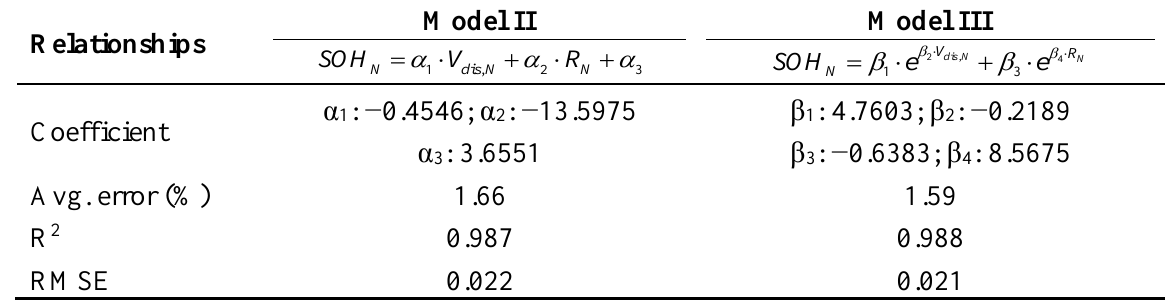
Table 1. Parameters of regression model II and